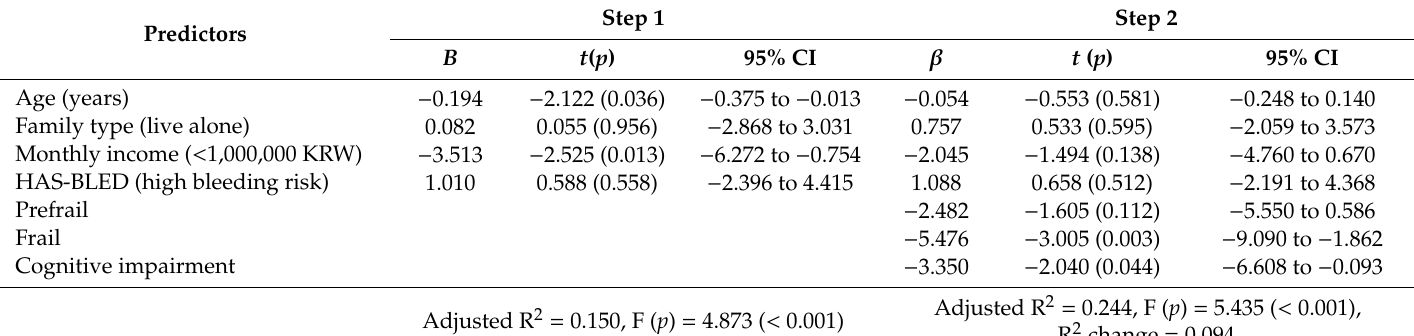
Table 5. Hierarchical linear regression analysis of self-care behaviors in female patients with AF ( n =